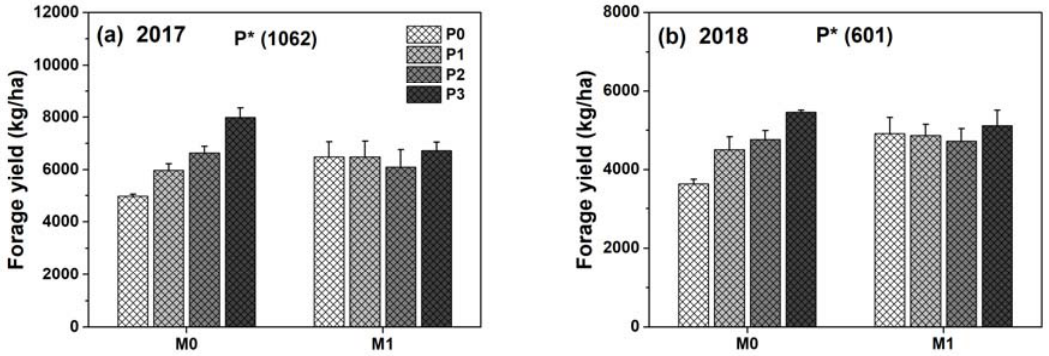
Figure 5. Effect of film mulch (M) and P fertilization (P) on alfalfa forage yield in ( a ) 2017 and ( b ) 2018. M0P0, M0P1, M0P2, M0P3, M1P0, M1P1, M1P2, and M1P3 represent no mulch (M0) and mulch (M1) with four levels of P (P0, P1, P2, and P3), respectively. *, p ≤ 0.05. Numbers in parentheses are LSD values among treatments ( p = 0.05). Error bars show one standard error of the mean.